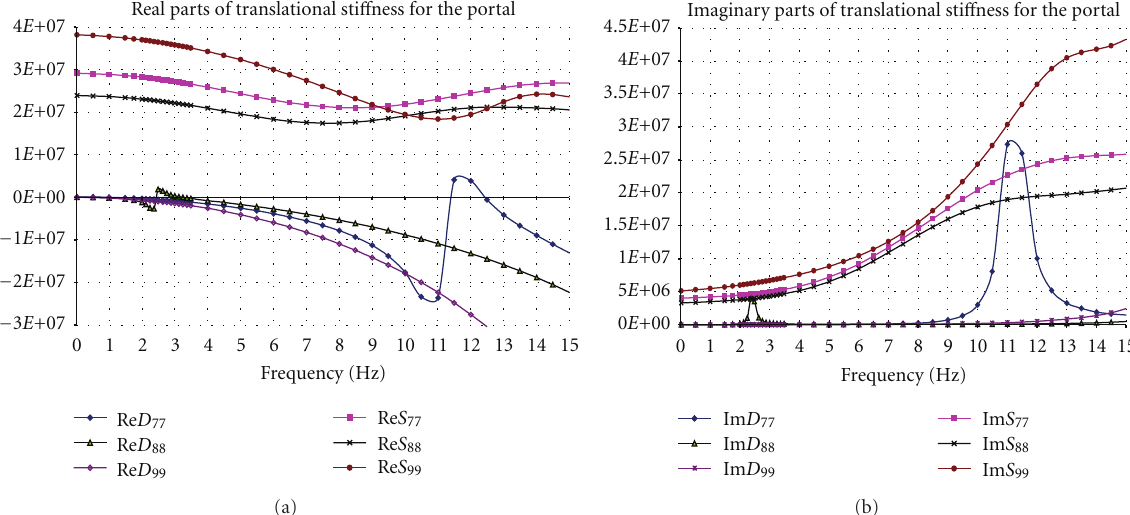
Figure 3: Translational dynamic sti ff ness of the soil and the structure along axes Ox , Oy , Oz for the portal